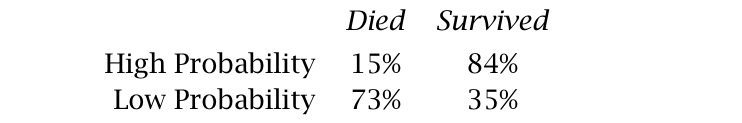
Mean estimates (converted to percentages) of the number of pas- sengers who died/survived as a function of scenario (High versus Low Probability) and question asked ( died versus survived